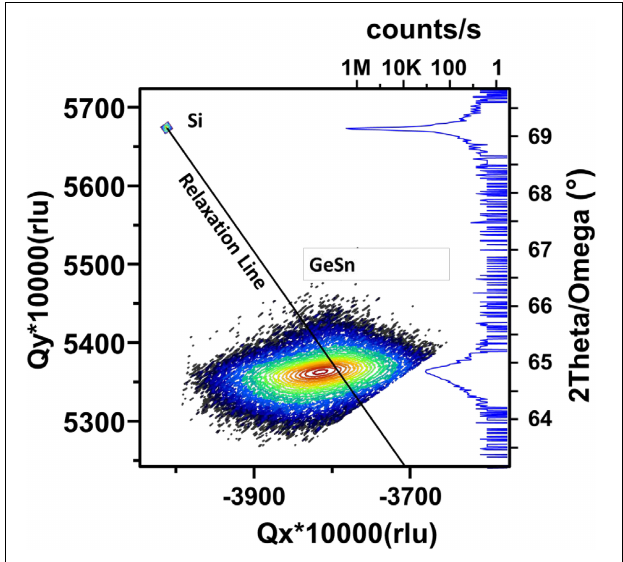
FIGURE 4 | X-ray diffraction 2 θ – ω scan along (004) and RSM map around ( ¯ 2 ¯ 24) reflection of a representative Ge 1 − x Sn x film grown directly on Si.